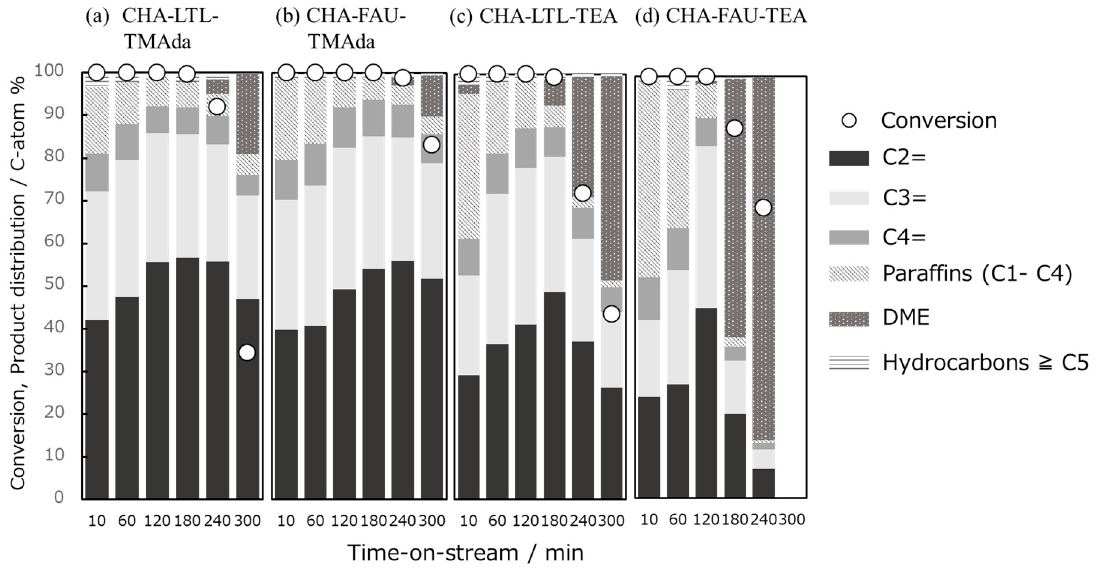
Figure 8. The methanol to olefins (MTO) reaction over ( a ) CHA–LTL–TMAda, ( b ) CHA–FAU–TMAda, ( c ) CHA–LTL–TEA, and ( d ) CHA–FAU–TEA.